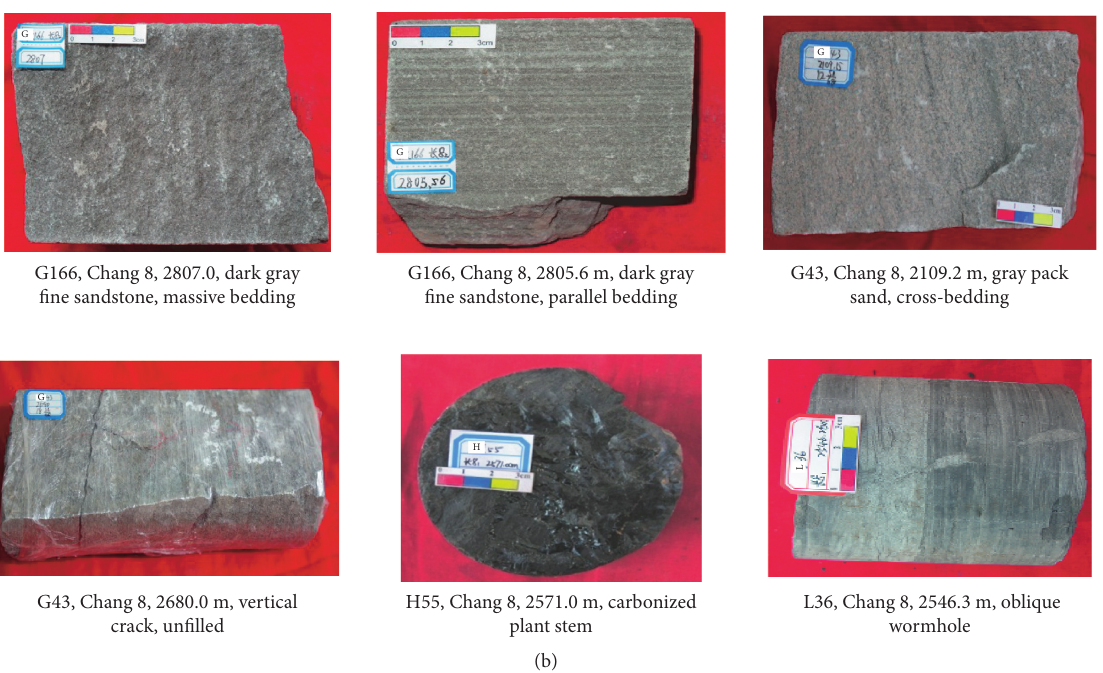
Figure 2: The sedimentary facies of well G20 (a) and typical rock sedimentary structure (b) in the study